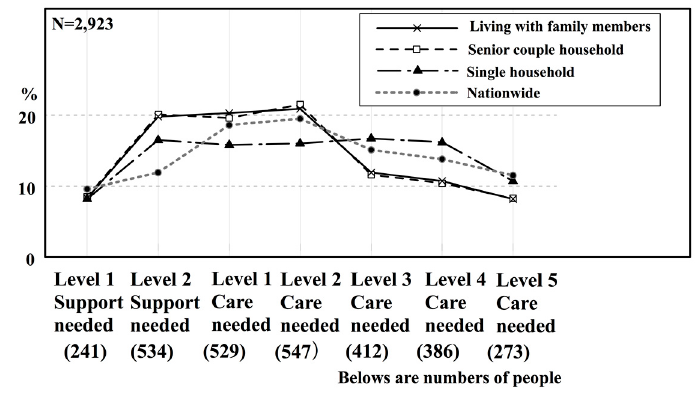
Figure 5. Composition of the need for elderly care according to household type in K City who are 65 years or older and are receiving care (Nationwide data is from [50]).